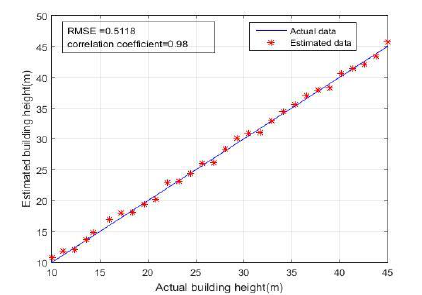
Fig.5. Accuracy evaluation of the building-height.